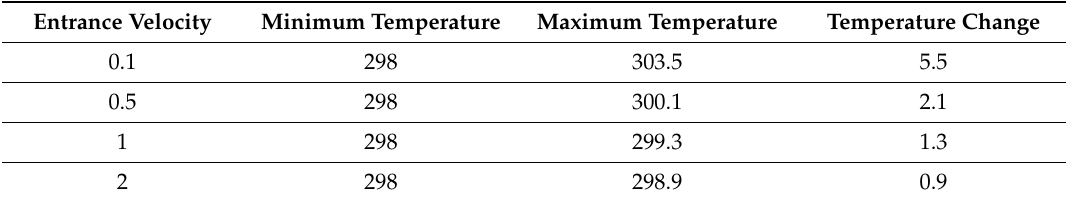
Figure 9. Maximum and minimum temperature of cooling plate. 5.3. Influence of Ambient Temperature